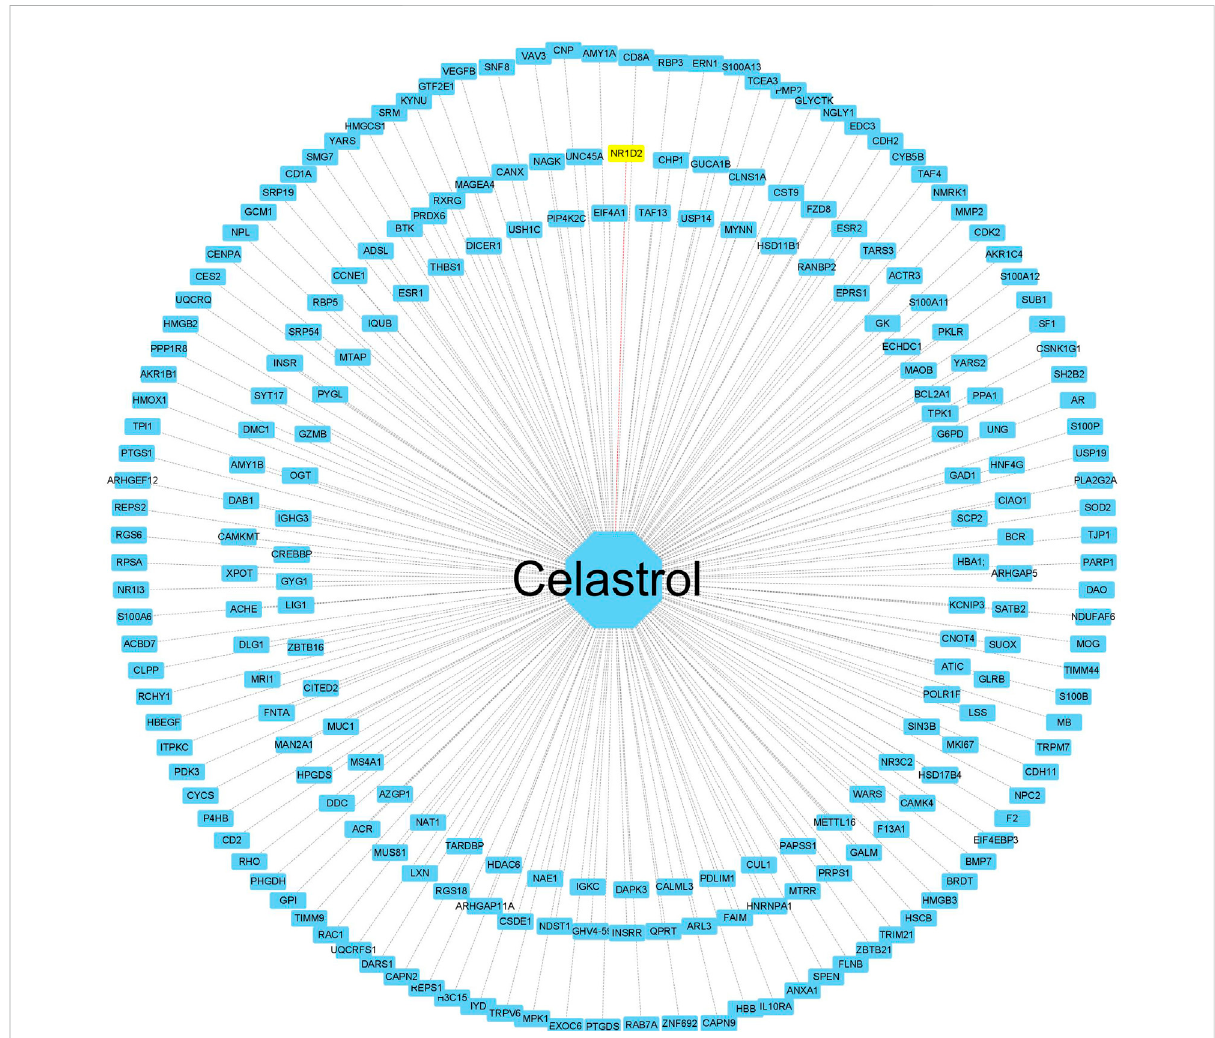
FIGURE 7 Constructionofthecelastrolpharmacophoretarget network.The “ drug – pharmacophoretarget ” network.Thedrug ryanodine isinthemiddle, and the network dots are the annotated successful pharmacophore gene targets (yellow indicates the drug and the corresponding disease target gene). The middle line is the target relationship